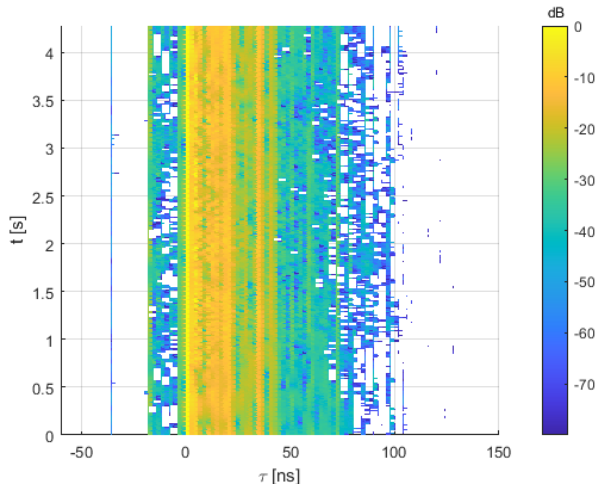
Figure 11. Measured PDPs inside the laboratory.